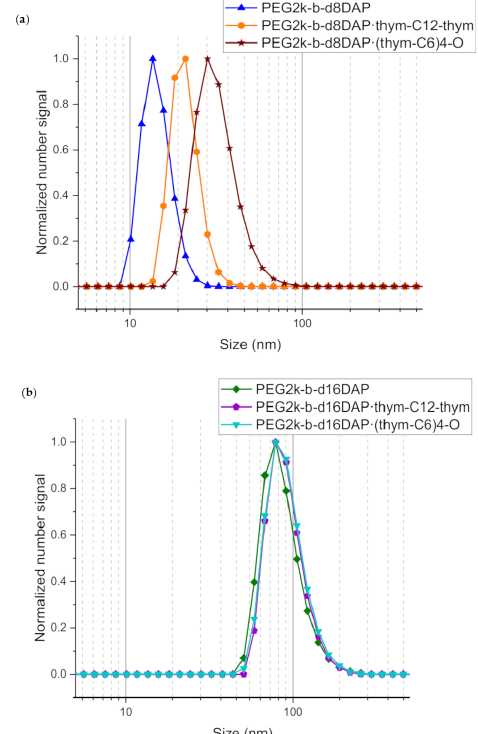
Figure 8. Number size distributions recorded by the DLS of supramolecular cross-linked LDBCs self- assemblies prepared by nanoprecipitation from either PEG 2k - b -d8DAP ( a ) or PEG 2k - b -d16DAP ( b ) and two thymine crosslinkers, either thym-C 12 -thym or ( (thym-C 6 ) 4 -O . The DLS of PEG 2k - b -d8DAP and PEG 2k - b -d16DAP self-assemblies (without incorporation of the supramolecular crosslinkers) are also included as